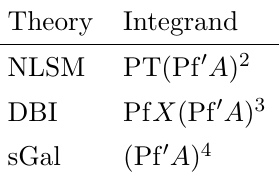
Table 1 . A summary of CHY integrands for a selection of scalar